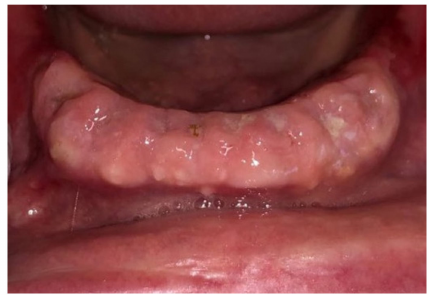
Figure 7. 7 days after surgery, Group A.